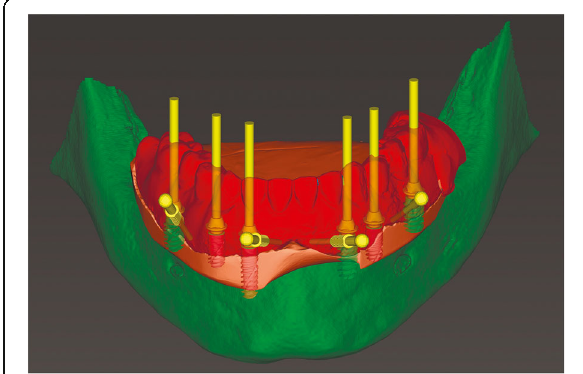
Fig. 2 Matching DICOM and STL files, prosthetically driven implant surgical planning